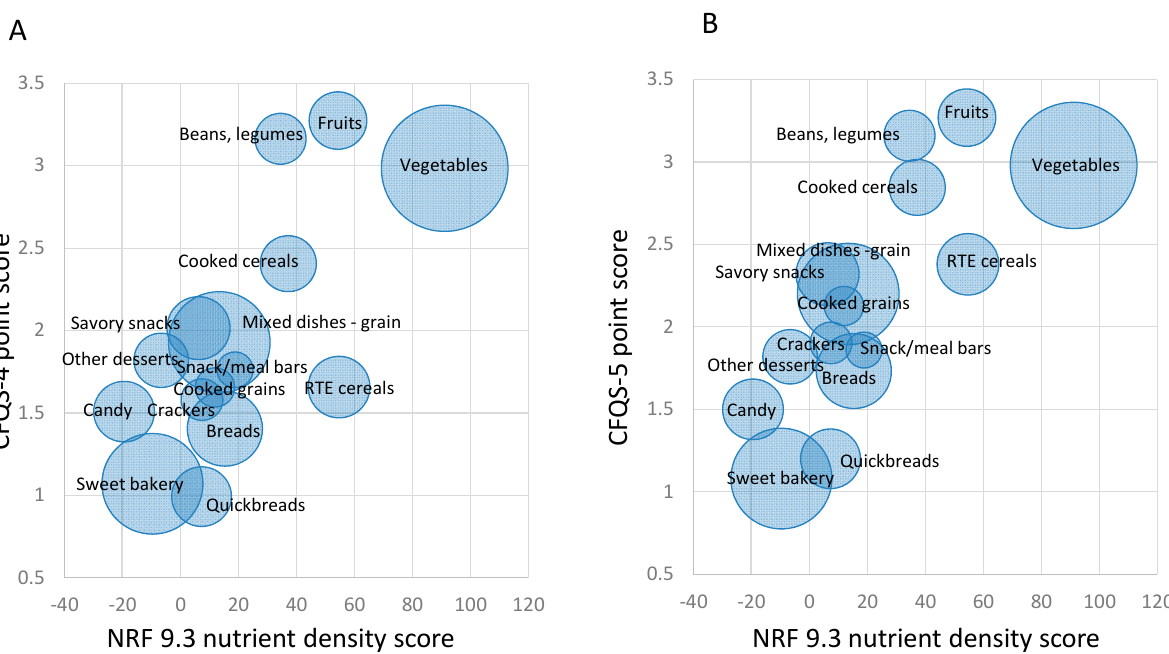
Figure 3. Relation between Carbohydrate Food Quality Scores (CFQS) and NRF9.3. N = 2596. ( A ) CFQS-4 vs. NRF9.3 Scores for 15 Carbohydrate Food Categories ( B ) CFQS-5 vs. NRF9.3 Scores for 15 Carbohydrate Food Categories (The size of the circles represents the number of higher-quality carbohydrate foods in each food category).